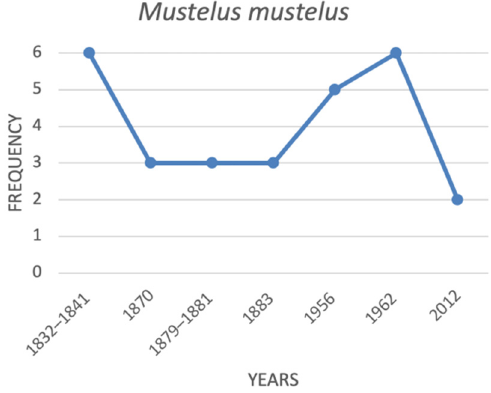
Figure 8. Temporal trend of Mustelus mustelus.